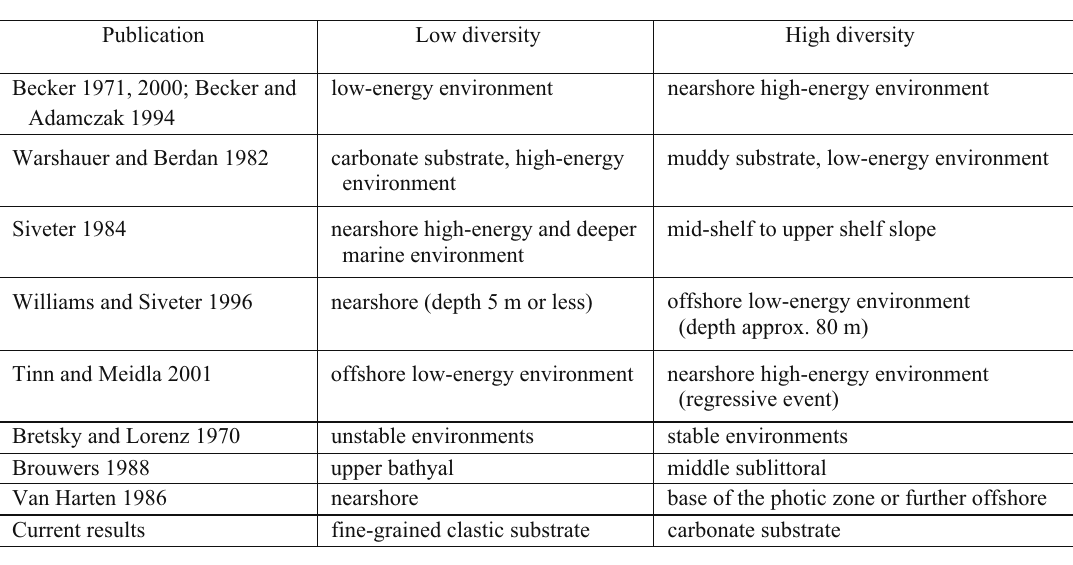
Table 6. Previous studies of ostracod diversity in relation to ecological parameters